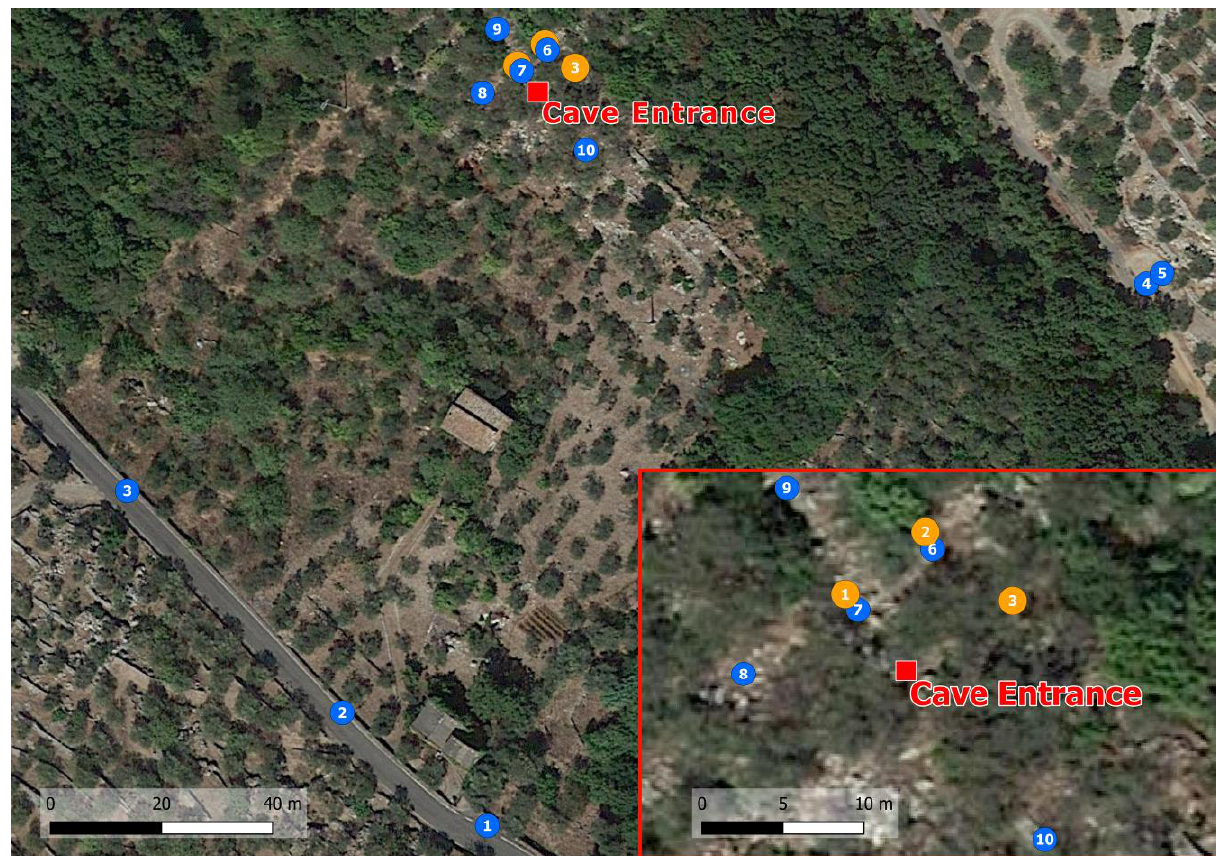
Figure 1 – The GCP acquired for the internal (orange) and outside (blue)